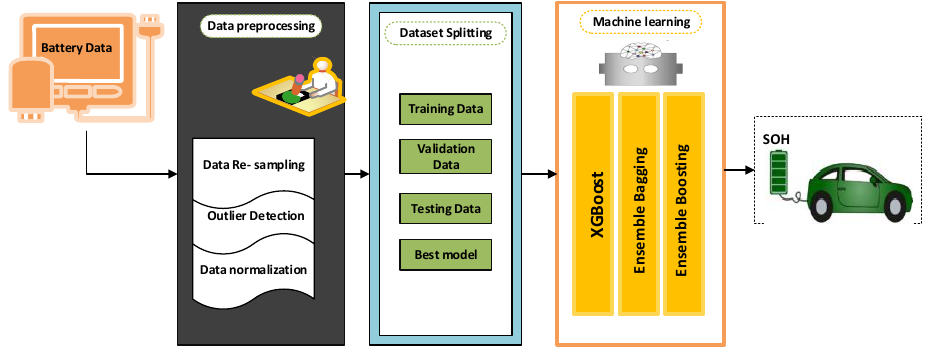
Figure 1. Schematic of the proposed hybrid framework